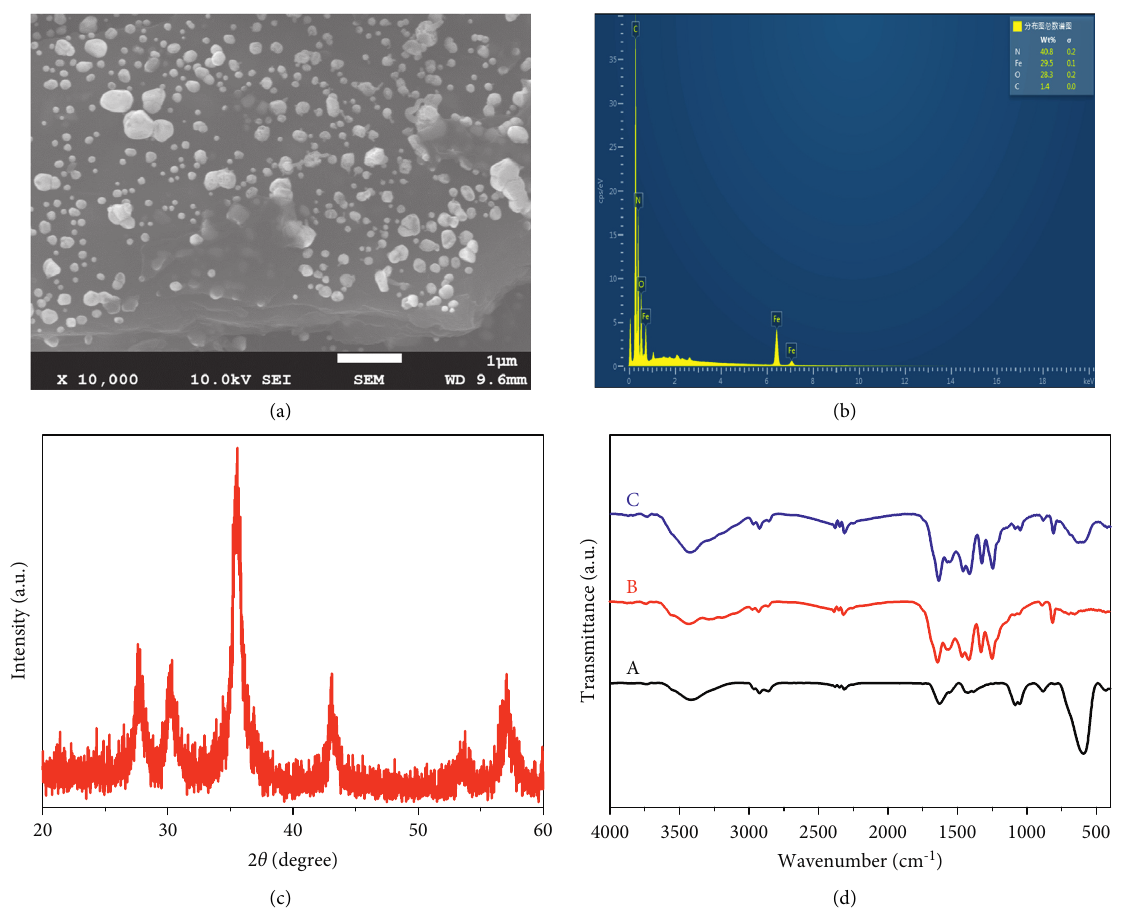
Figure 1: (a) SEM, (b) EDX, and (c) XRD of g-C 3 N 4 @Fe 3 O 4 . (d) FTIR of (A) Fe 3 O 4 , (B) g-C 3 N 4 , and (C) g-C 3 N 4 @Fe 3 O.